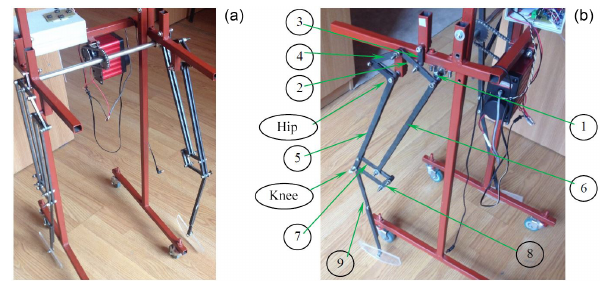
Figure 23. A view of exoskeleton manufactured prototype: (a) iso- metric view; (b) lateral view.